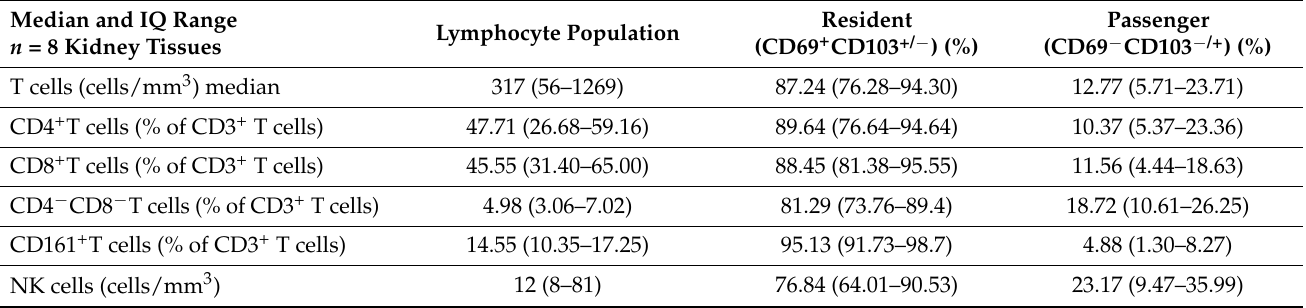
Table 2. Lymphocyte populations following direct enzymatic dissociation of kidney